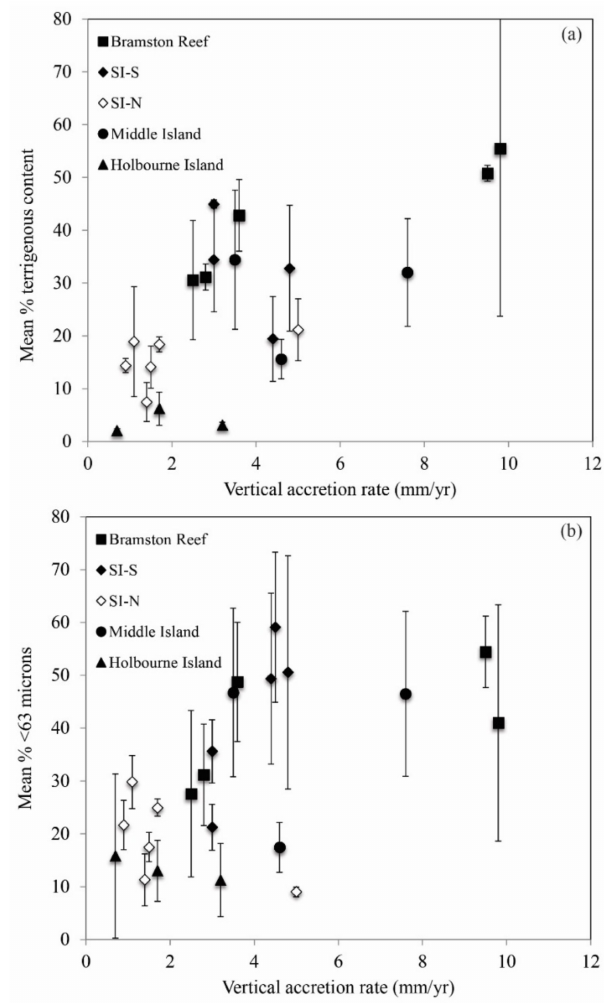
Figure 4. Estimated vertical reef accretion rates (based on 230 Th ages of coral material within reef cores) and ( a ) the mean terrigenous content or ( b ) the mean mud content (<63 µ m) of the sediment that contributed to the reef matrix during the time period for which each growth rate was estimated. Vertical error bars show one standard deviation for the terrigenous or mud content. SI-S is Stone Island South reef, and SI-N is Stone Island North